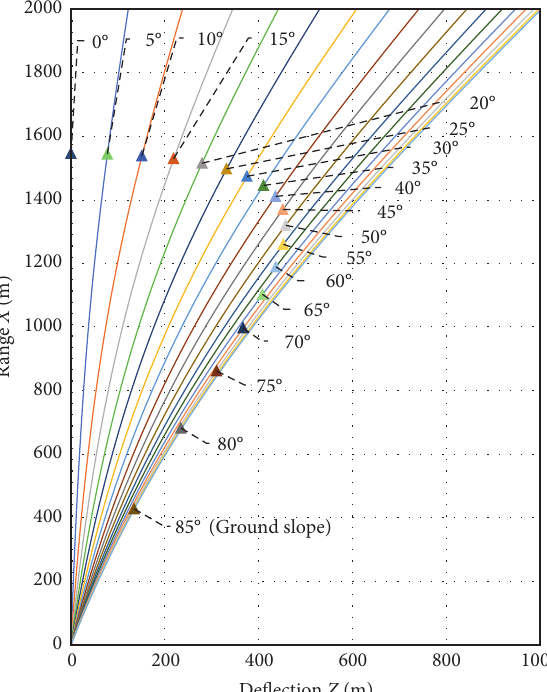
Figure 2: Relationships of range and deflection using K2 Rifle and K100 Bullet.